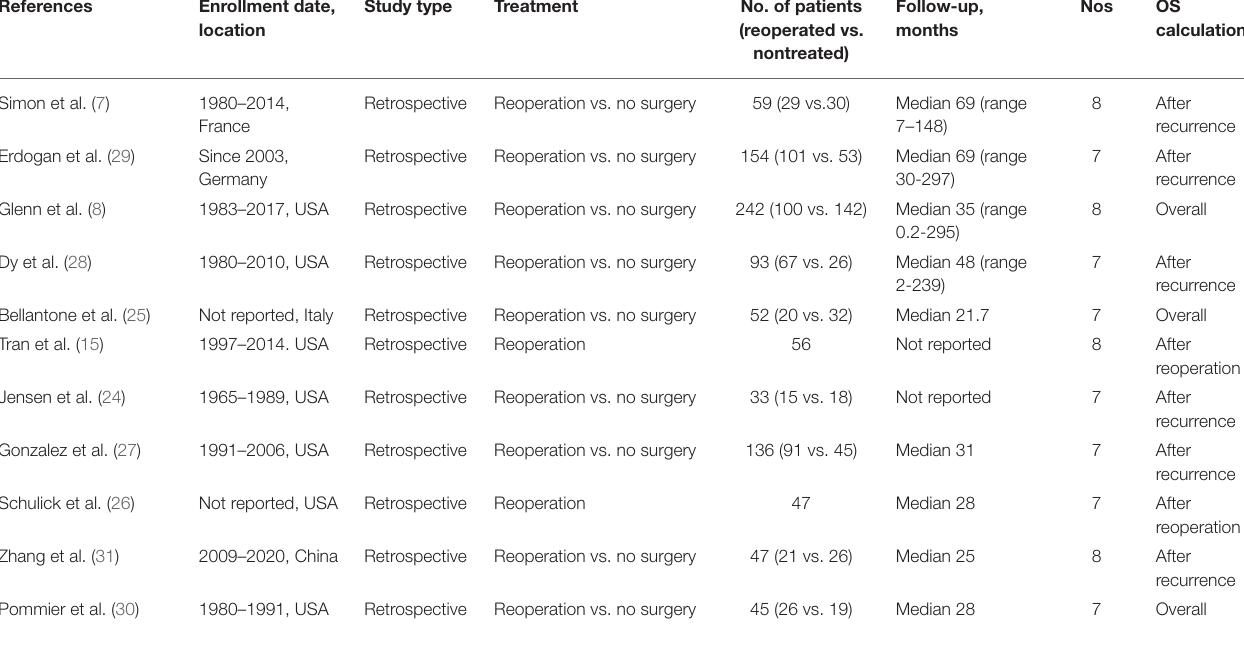
TABLE 1 | Clinical characteristics of the included